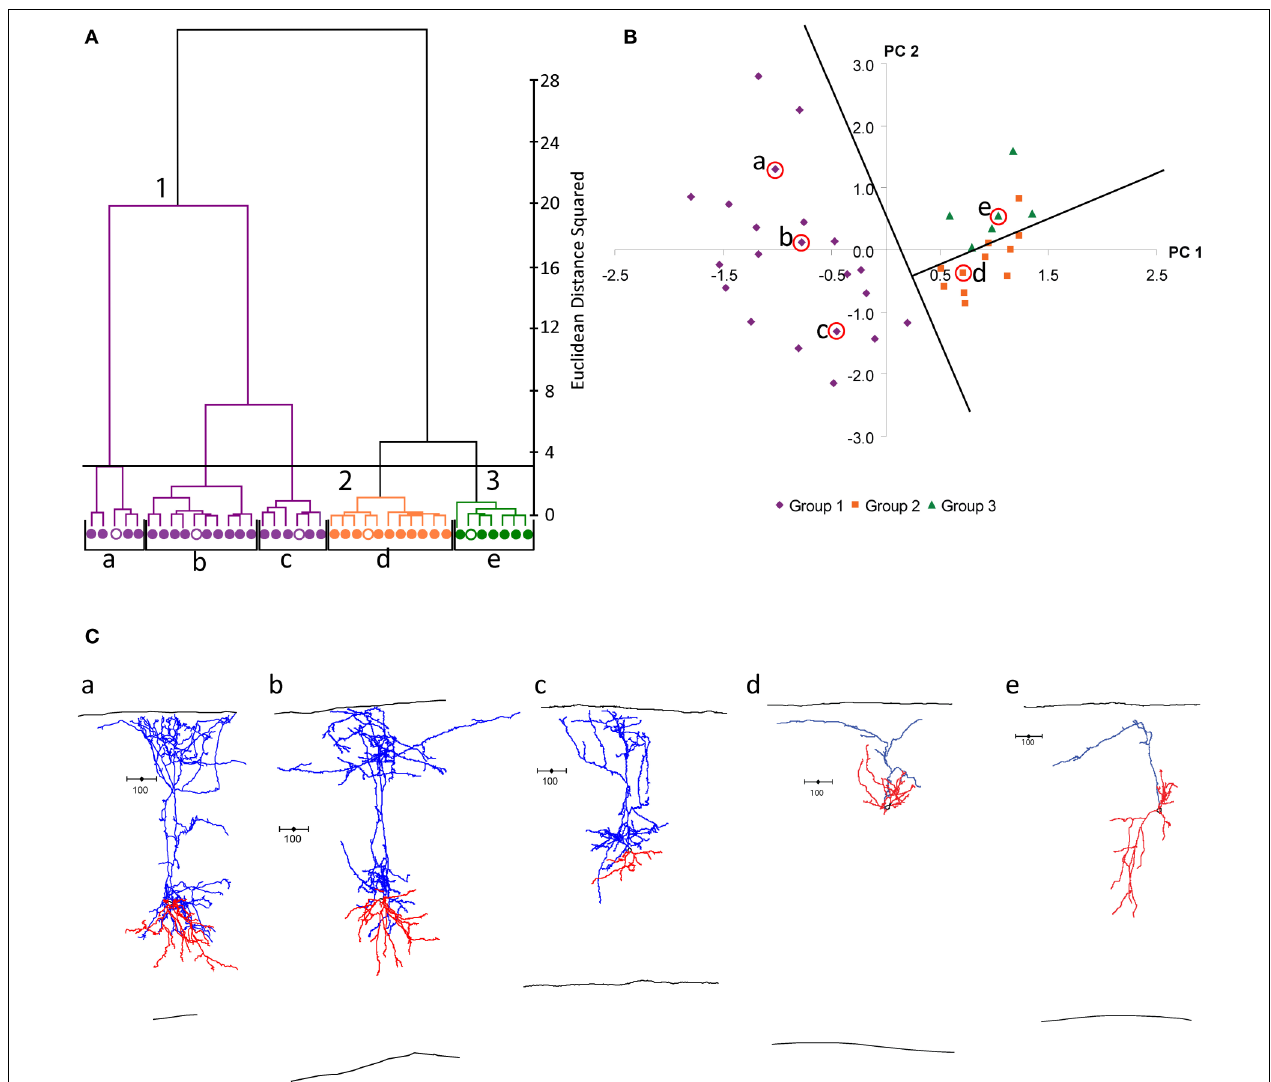
cut-off linkage distance. The groups discussed in the text are colored: group 1 in purple, group 2 in orange and group 3 in green. (B) Scatterplot of dataset in principal component space. The x -axis represents the fi rst principal component (PC1) and the y -axis represents the second principal component (PC2). Centroids of clusters are labeled and circled in red. Orthogonal lines separating the three groups are shown. (C) Neurolucida reconstructions of representative cells of each cluster. Axons are shown in blue and dendrites in